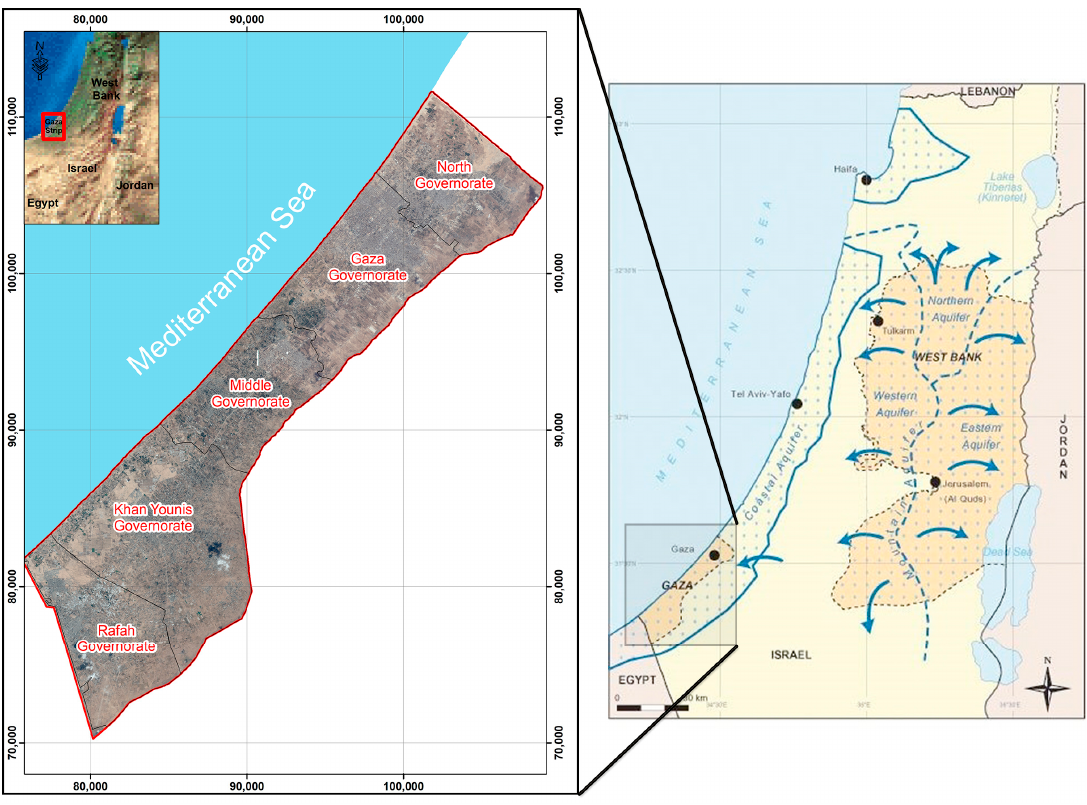
Figure 1. Regional coastal aquifer and Gaza Strip location (after [19,20]).